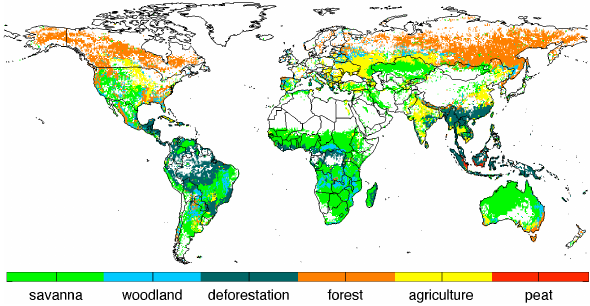
Fig. 13. Dominant fire type in each 0.5˚ grid cell based on carbon emissions. Savanna fires include grassland fires; deforestation includes degradation. Woodland and savanna fires were separated based on the relative contributions from woody or herbaceous fuels to total emissions, respectively.